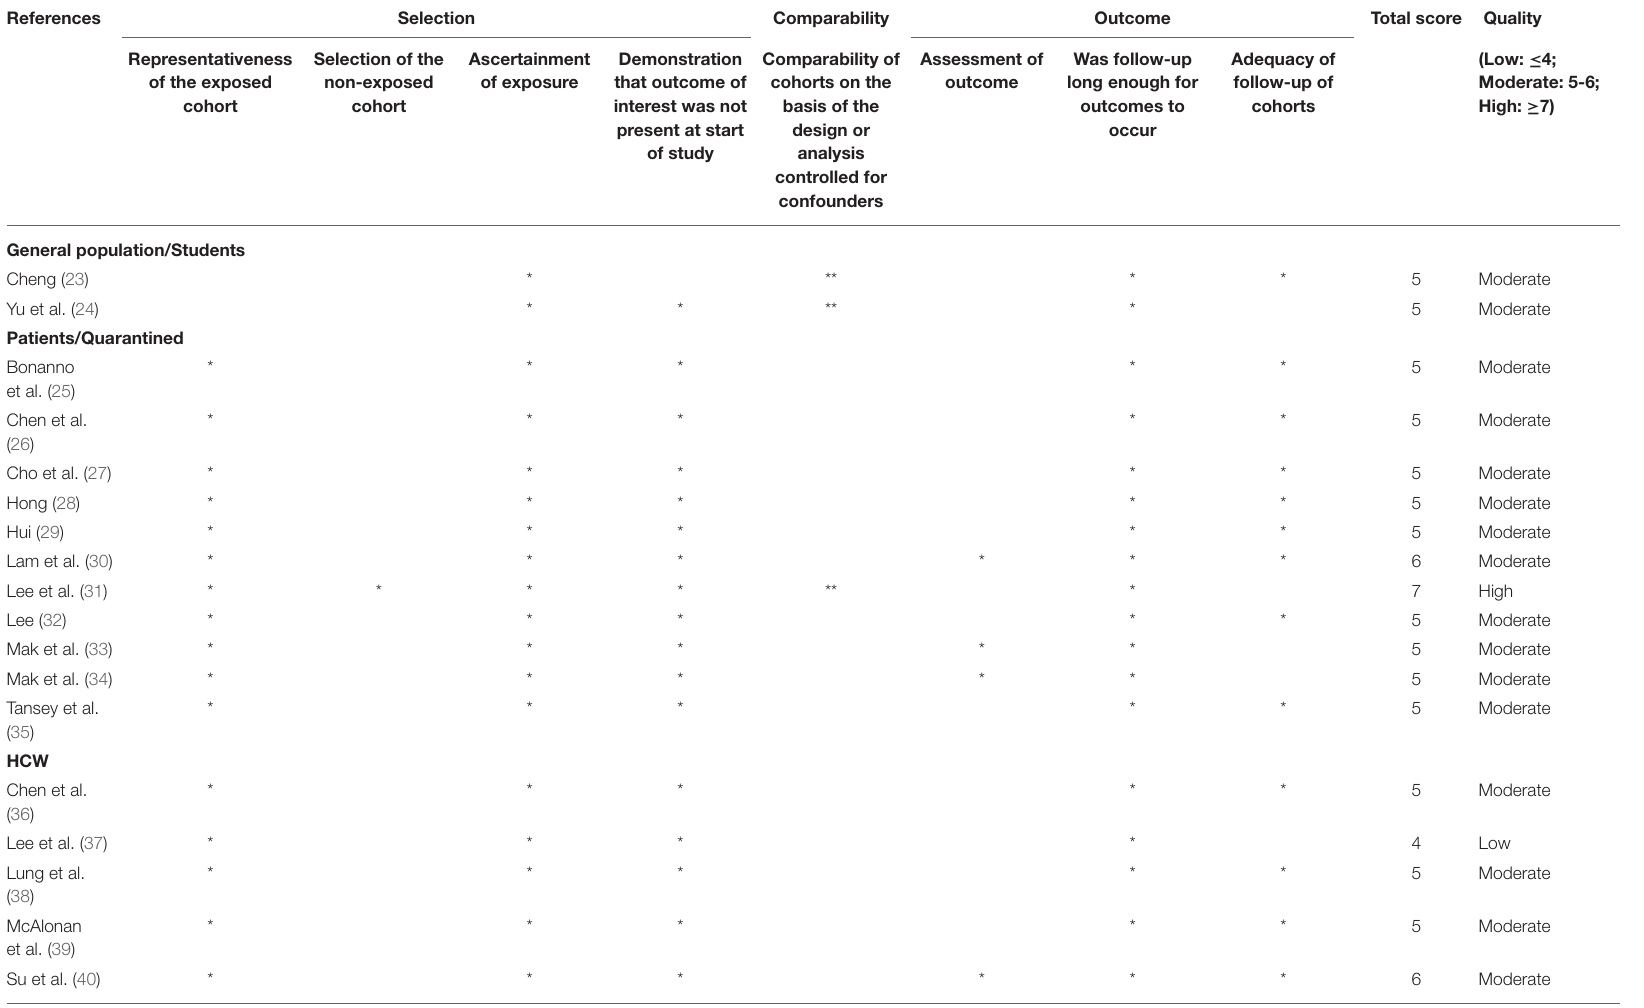
TABLE 3 | Newcastle–Ottawa Scale quality assessment for cohort studies ( n =